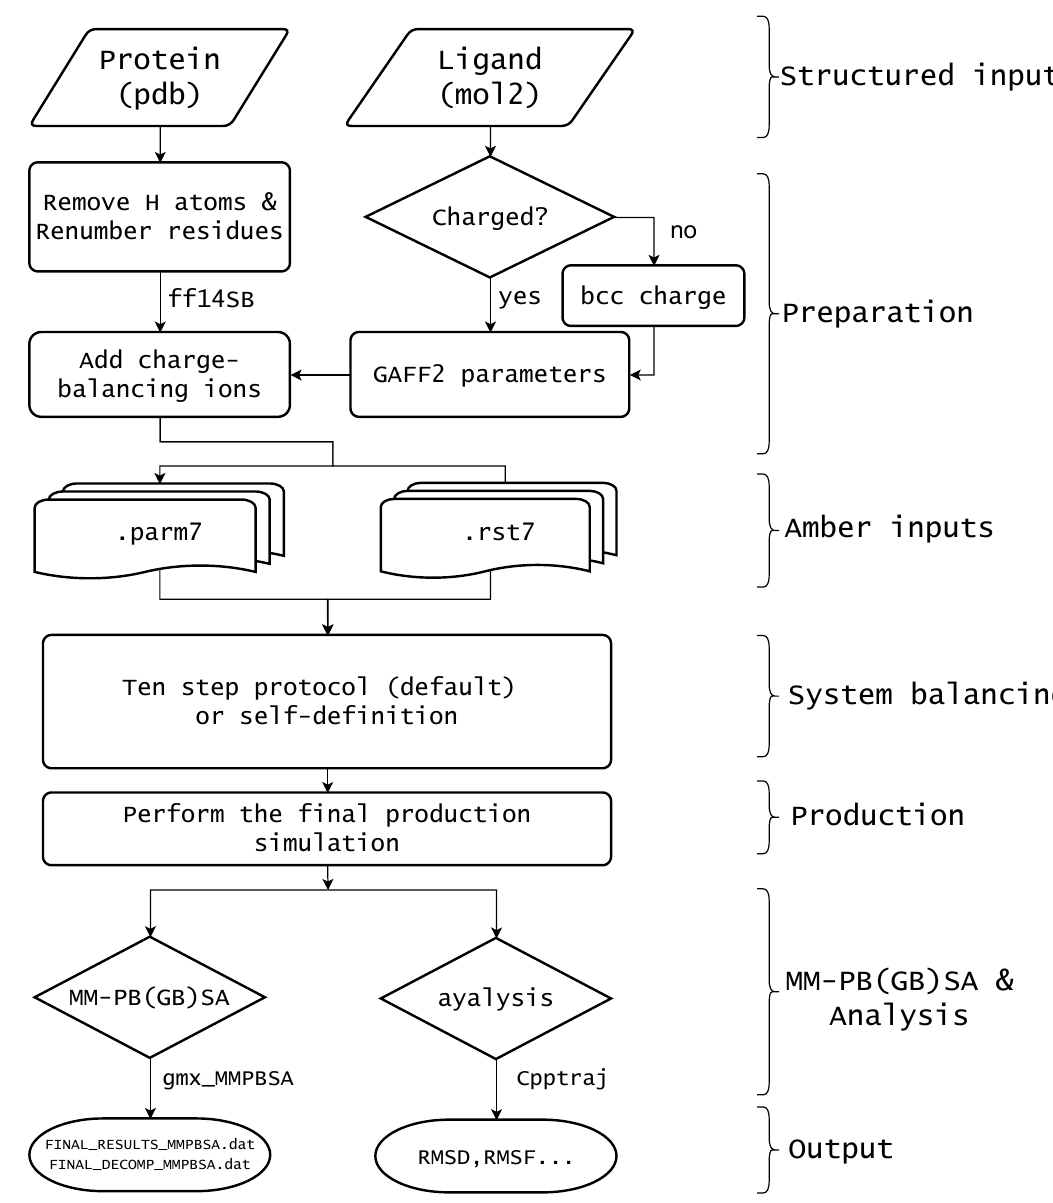
Figure 1. Workflow of the script AmberMDrun, which depends on AmberTools, Amber (optional) [5], and gmx_MMPBSA [36]. The ten-step protocol [8] is set as the default system balancing method, and users can also define their own balancing method. Using gmx_MMPBSA, MM-PBSA or MM-GBSA binding free energies are